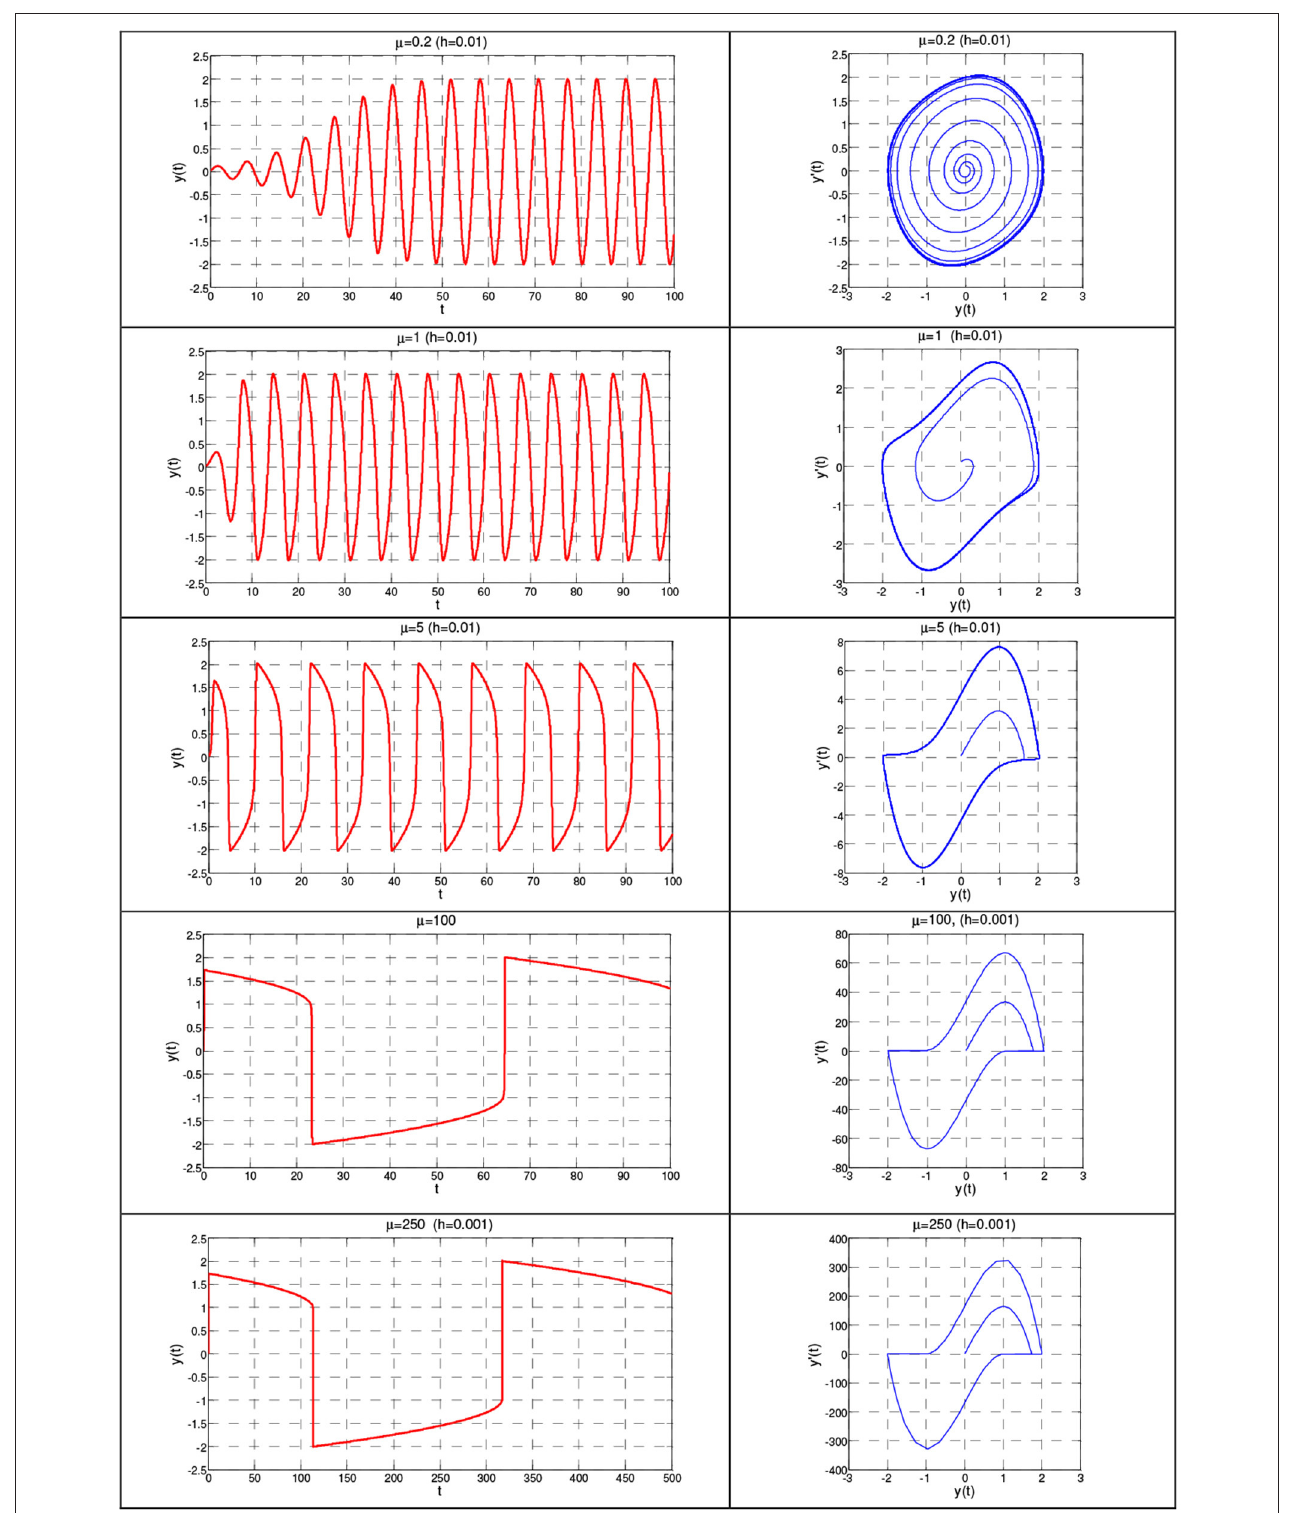
FIGURE 9 | Solution y ( t ) and phase plane in Example 9.